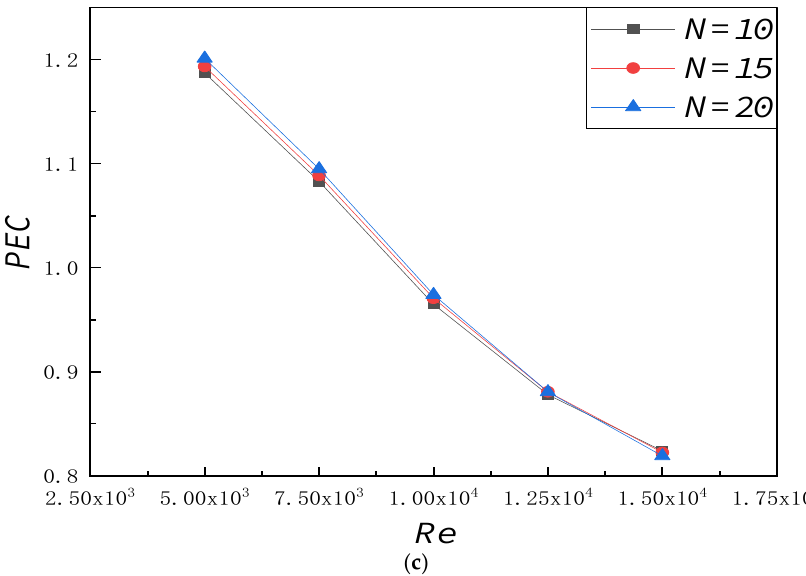
Figure 10. Effect of different factors on heat transfer and flow performance: ( a ) the angle α , ( b ) the height H , ( c ) the number N .